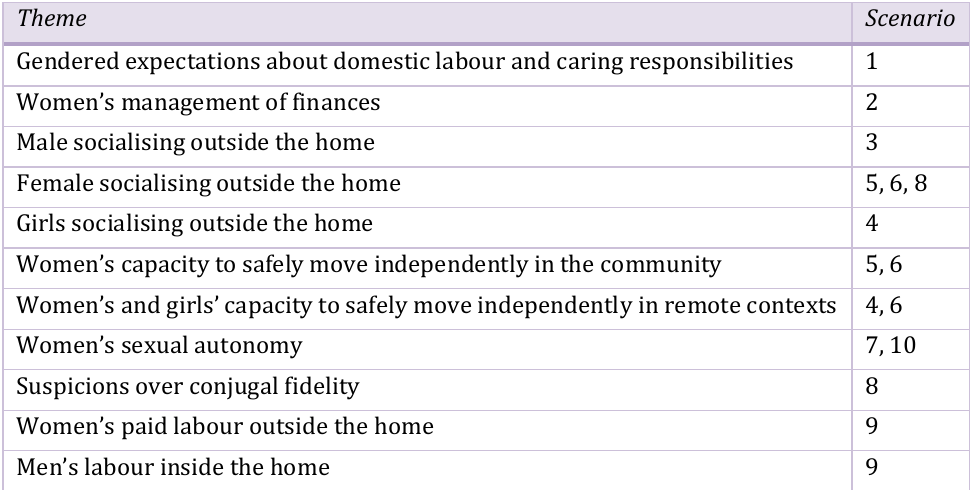
Table 1: Scenario description